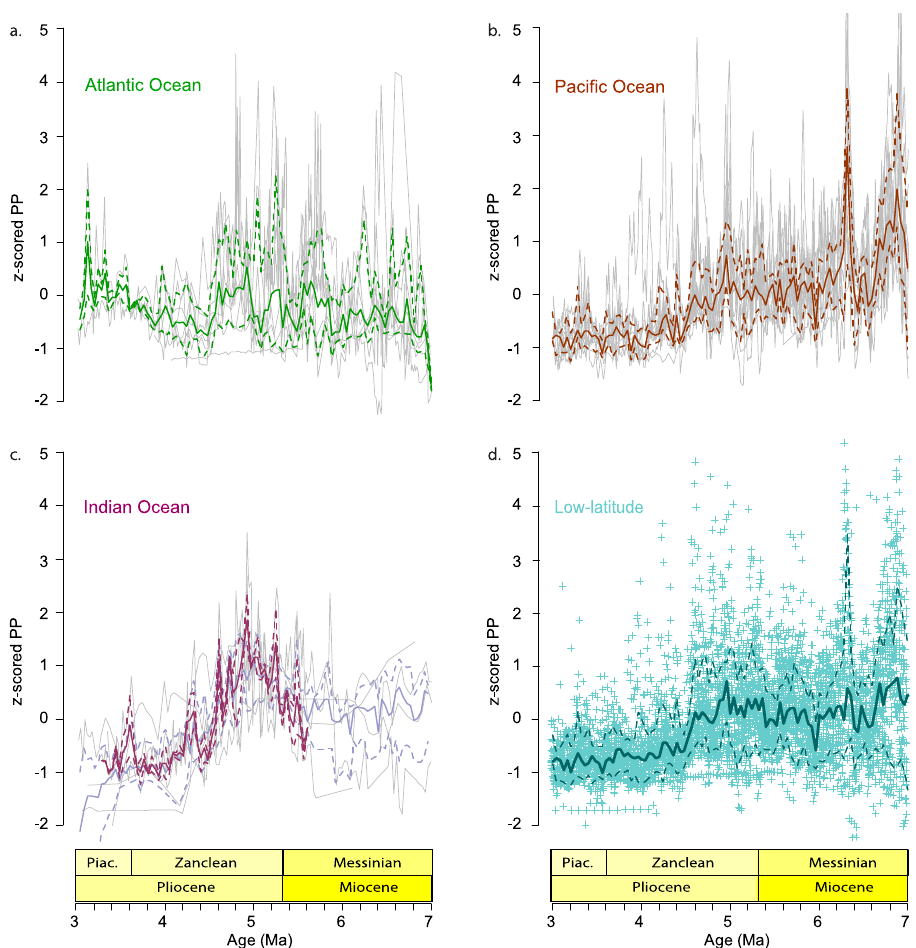
Fig. 2 Standardized marine paleoproductivity (PP) records across the late Miocene - Pliocene. The median (solid lines) of binned and z-scored PP data (grey lines in a – c and crosses in d ) is shown for a the Atlantic Ocean, b the Paci fi c Ocean, c the Indian Ocean and d all vetted records combined. Dashed lines indicate the 15.9 and 84.1 percentiles (i.e. the central 68.2 percentiles) of the binned data. The Indian Ocean compilations ( c ) include the median of input records that scored 4 or 5 only (dark purple line) and that calculated including records that scored 3 (light purple line). Piac. = Piacenzian. Source data for this fi gure are provided as a Source Data fi